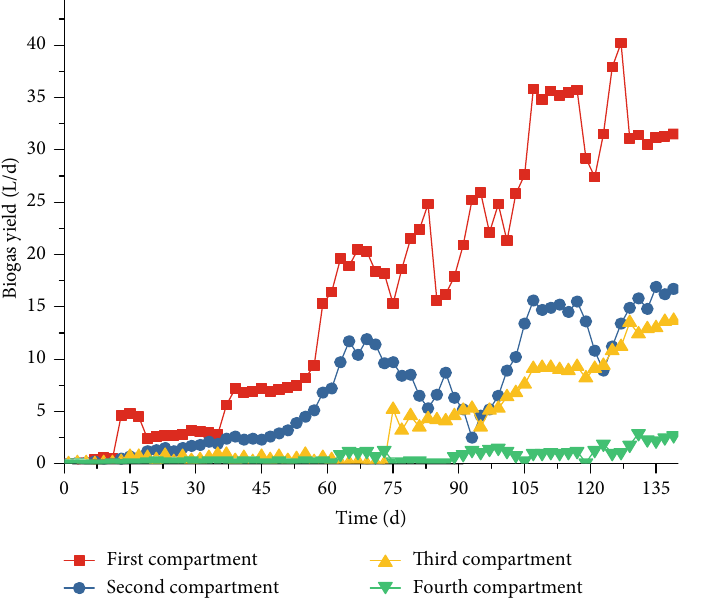
Figure 6: Biogas production in each